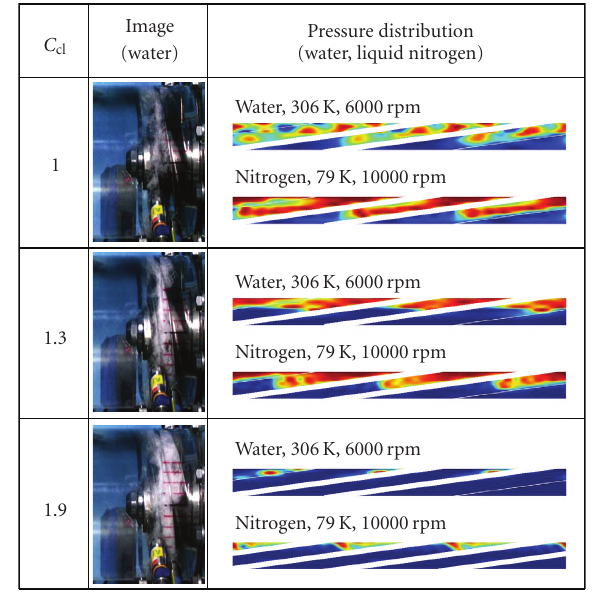
Figure 6: Visualization of cavity with direct images and indirect pressure distributions.